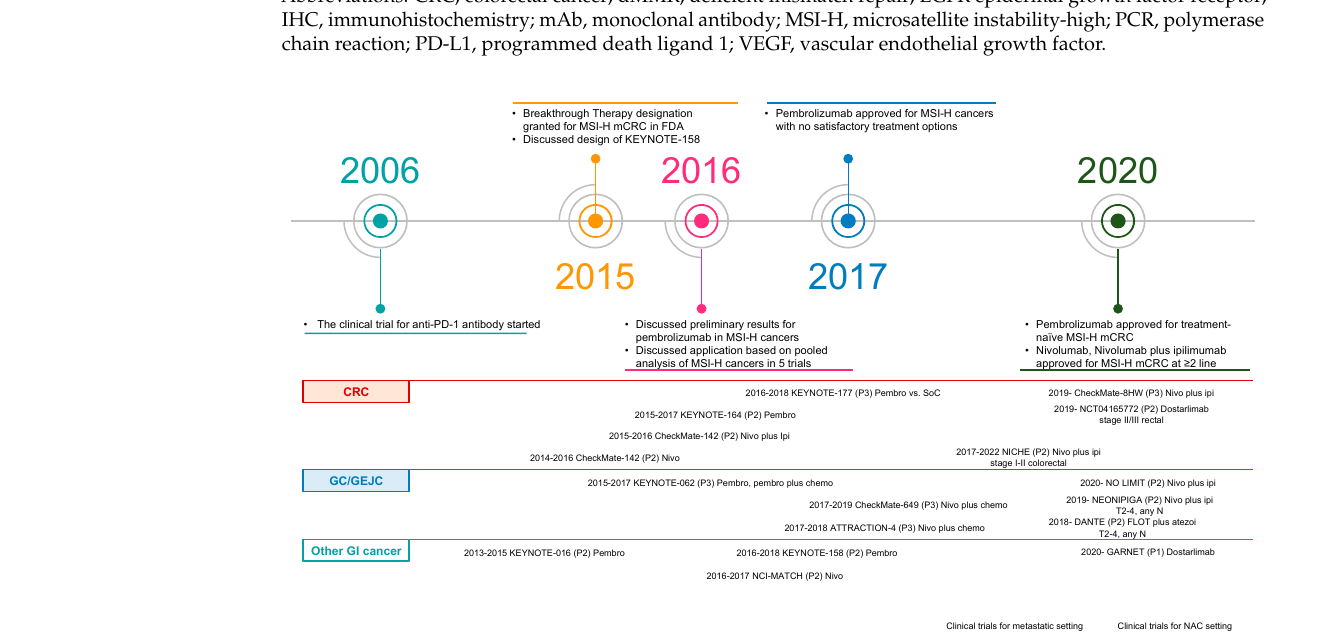
Figure 2. Timeline of events for immunotherapy MSI-H/dMMR application and clinical trials.